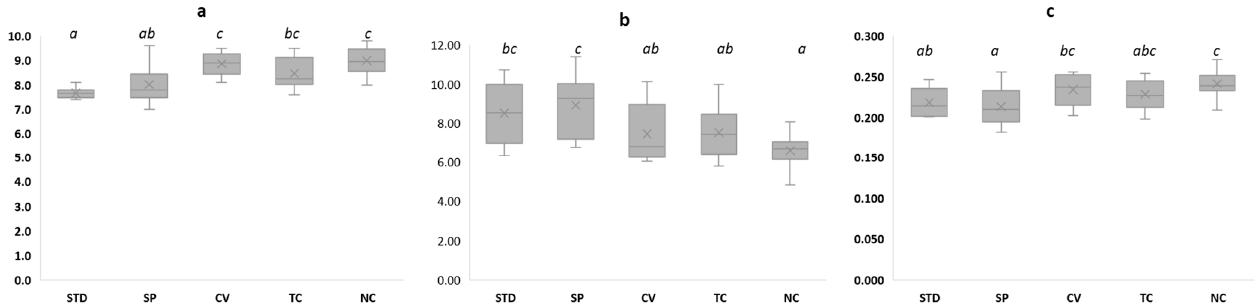
Figure 2. Rheological properties of vegetable creams as a function of microalgae. STD: standard; SP: Spirulina ( Arthrospira platensis ); CV: Chlorella vulgaris ; TC: Tetraselmis chui ; NO: Nannochloropsis oceanica . ( a ) Bostwick consistency (cm); ( b ) con- sistency coefficient (K); ( c ) flow behavior index (n). Different letters (a–c) in different bars indicate significant ( p < 0.05) differences between samples for the given parameter.